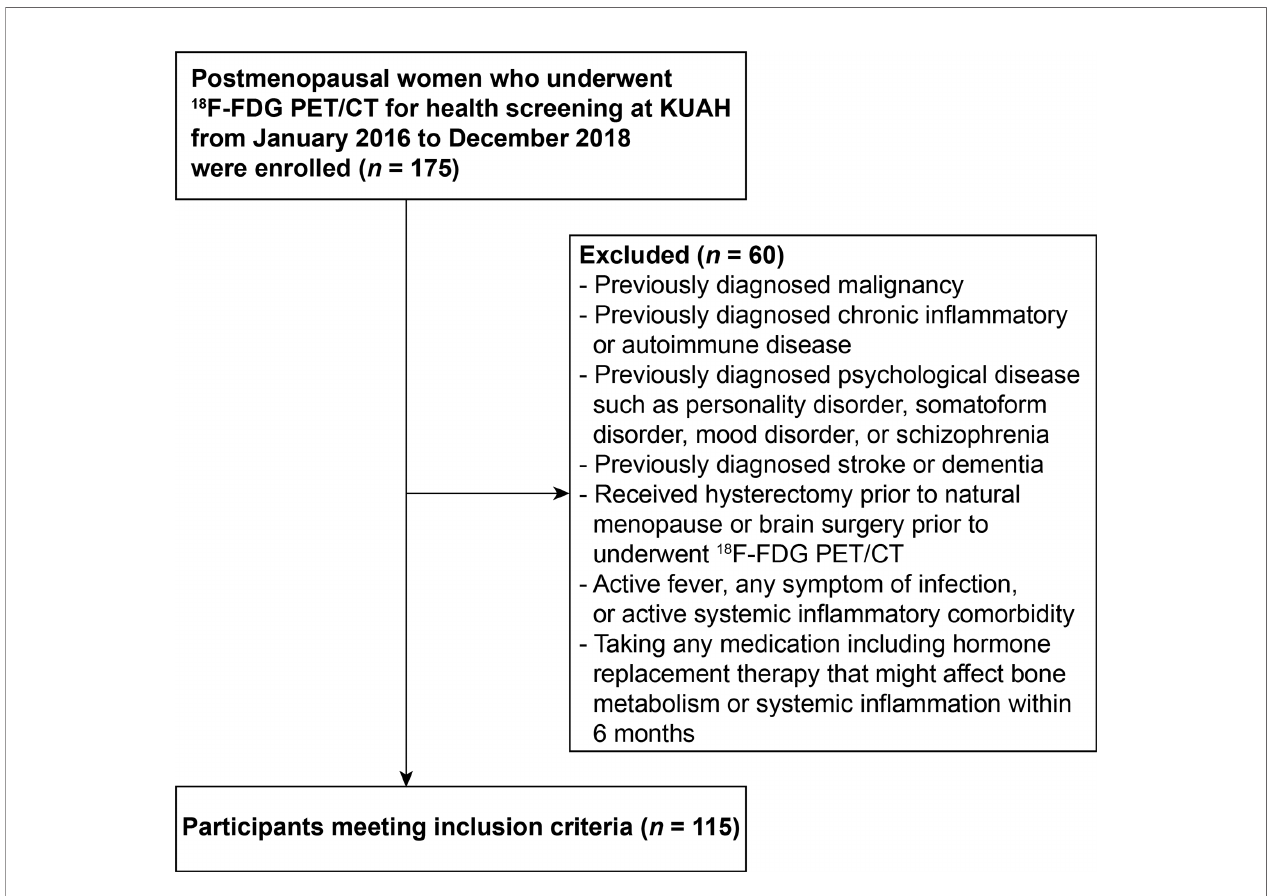
FIGURE 1 | The fl owchart of study design. 18 F-FDG PET/CT, 18 F- fl uorodeoxyglucose positron emission tomography/computed tomography; KUAH, Korea University Anam